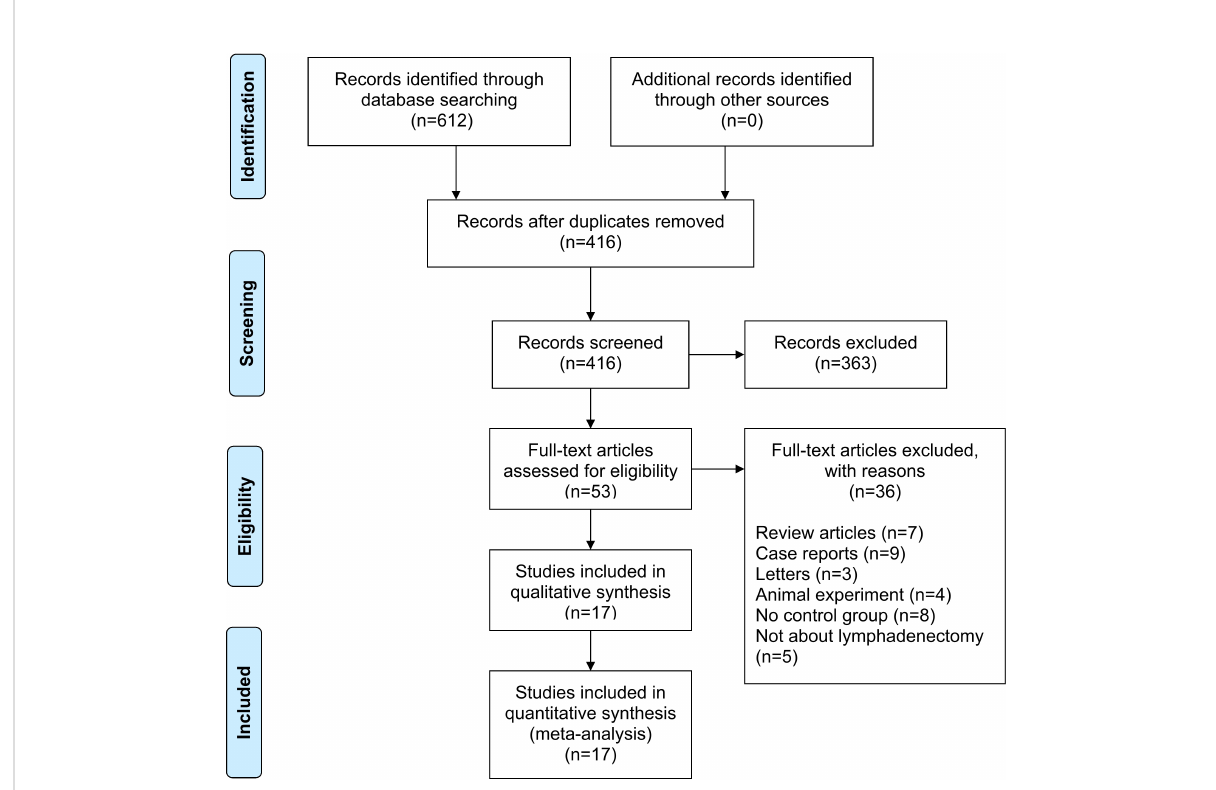
FIGURE 1 PRISMA fl owchart of literature search and selection process. PRISMA preferred reporting items for systematic review and